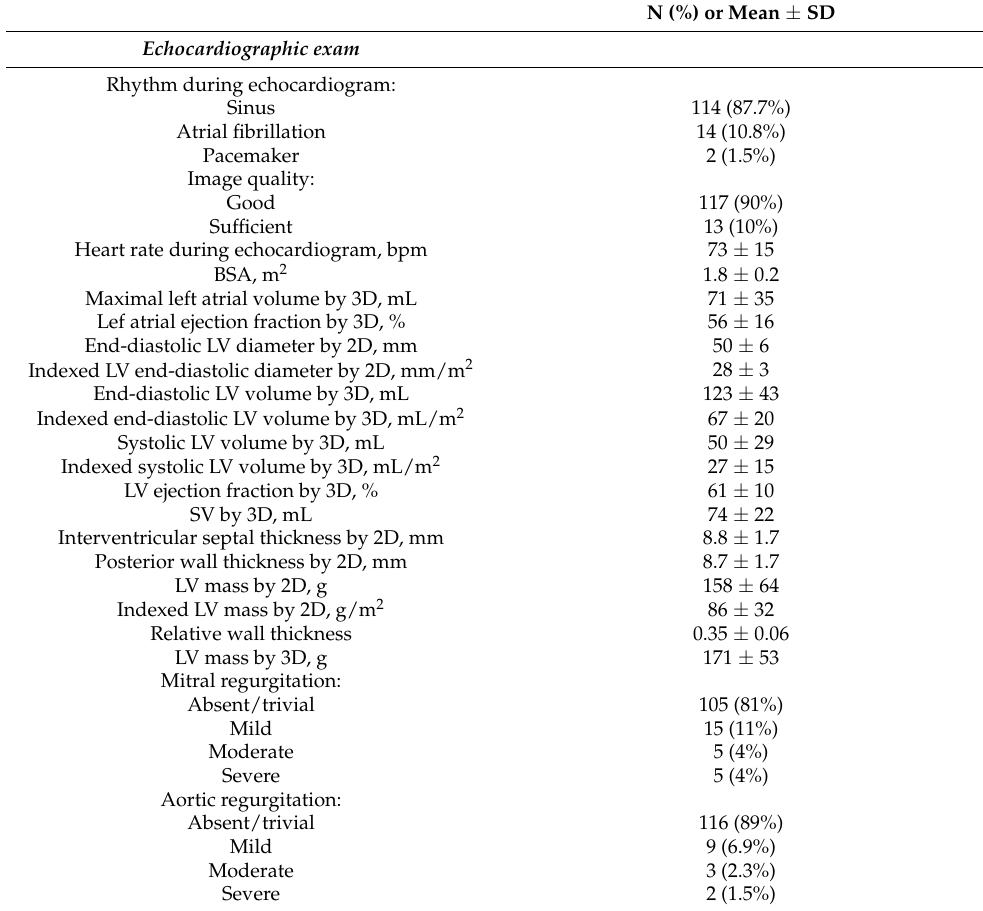
Table 2. Echocardiographic characteristics of the study